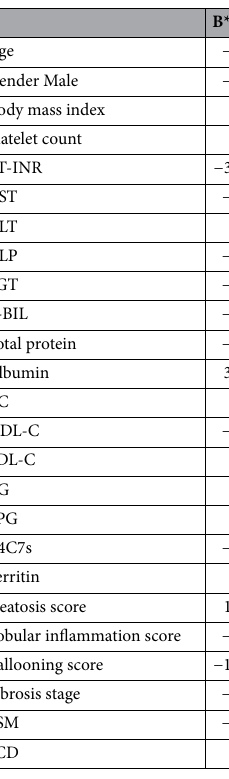
Table 3. Single regression analysis for factors associated with CAP. *Partial regression coefficient. Abbreviations: SE, standard error; SCD, skin–capsular distance; PT-INR, prothrombin time–international normalized ratio; AST, aspartate aminotransferase; ALT, alanine aminotransferase; ALP, alkaline phosphatase; γGT, γ-glutamyl transpeptidase; T-BIL, total bilirubin; TC, total cholesterol; HDL-C, high-density lipoprotein cholesterol; LDL-C, low-density lipoprotein cholesterol; TG, triglycerides; FPG, fasting plasma glucose; T4C7s, type IV collagen 7